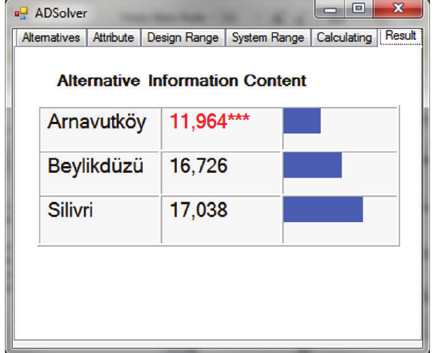
Figure 8: Entering the system ranges. Figure 9: Solution of the ADSolver for unweighted AD